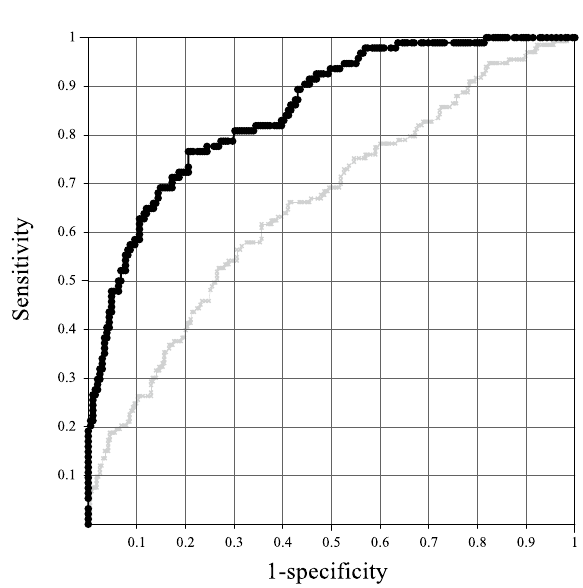
Figure 2. Receiver operating characteristic curve analysis of models that predicted 72-h mortality among patients with extremely high values of serum aspartate aminotransferase. Gray line indicates reference values, comprising age and aspartate aminotransferase (AST); black line indicates prediction mode, comprising alkaline phosphatase (ALP), creatine kinase (CK), sodium, pottasium, and phosphorus values. The predicted probability ( p ) for the 72-h mortality of the prediction model was calculated using the following formula: p = 1/ [1 + exp (-19.98 + 0.290( ALP 0.2 ) + 0.348log ( CK ) + 1.766( Na 0.2 ) + 1.568( K 0.2 ) + 0.474( P 0.8